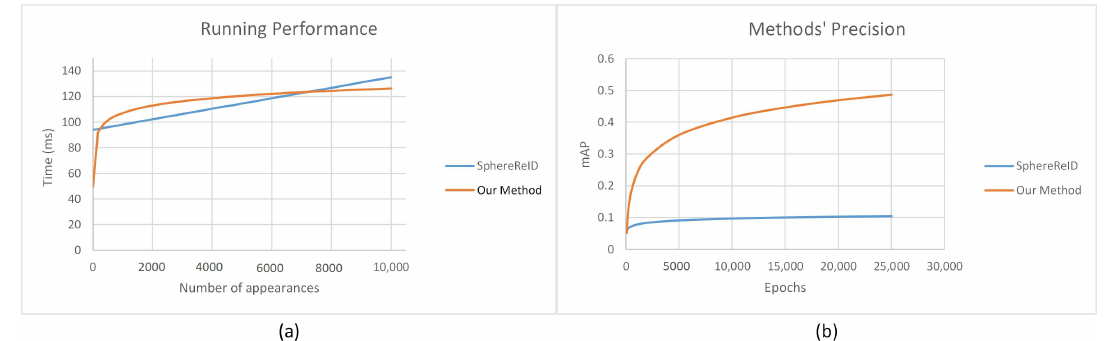
Figure 14. Comparison between the proposed method and another method based on deep metric embedding learning; ( a ) Comparison in terms of running time; ( b ) Comparison in terms of